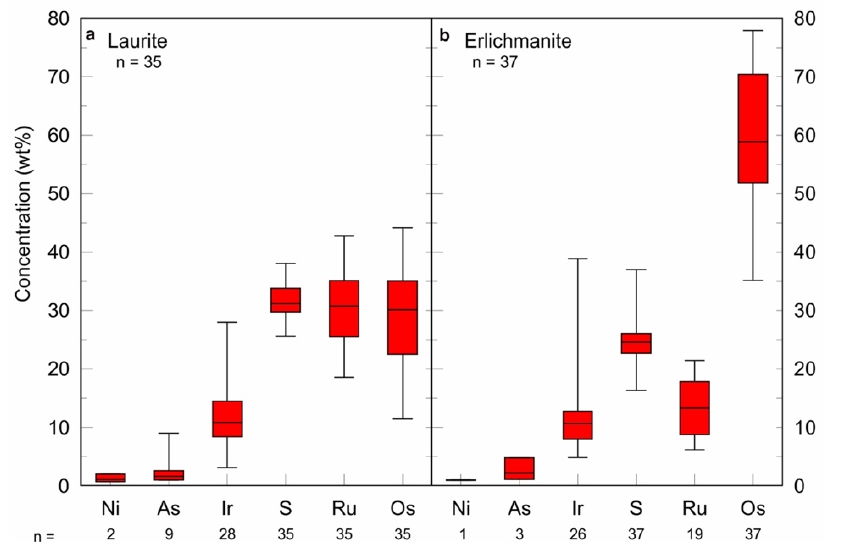
Figure 13. Multi-element box and whisker plots showing elemental variation (in wt%) in the com- position of ( a ) laurite and ( b ) erlichmanite grains. Whiskers represent the range of minimum and maximum values. The short line within each box represents the median value, which separates the box into two parts (i.e., lower 25th–50th percentile group and upper 50th–75th percentile). The n below the axis: number of grains containing the element of interest.